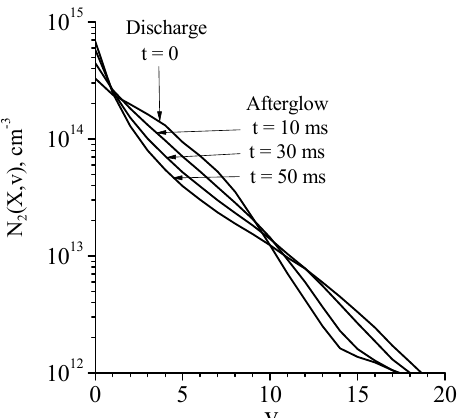
Figure 5. Ar + 1%N 2 . Calculated vibrational distribution functions in discharge ( t = 0) and afterglow ( t